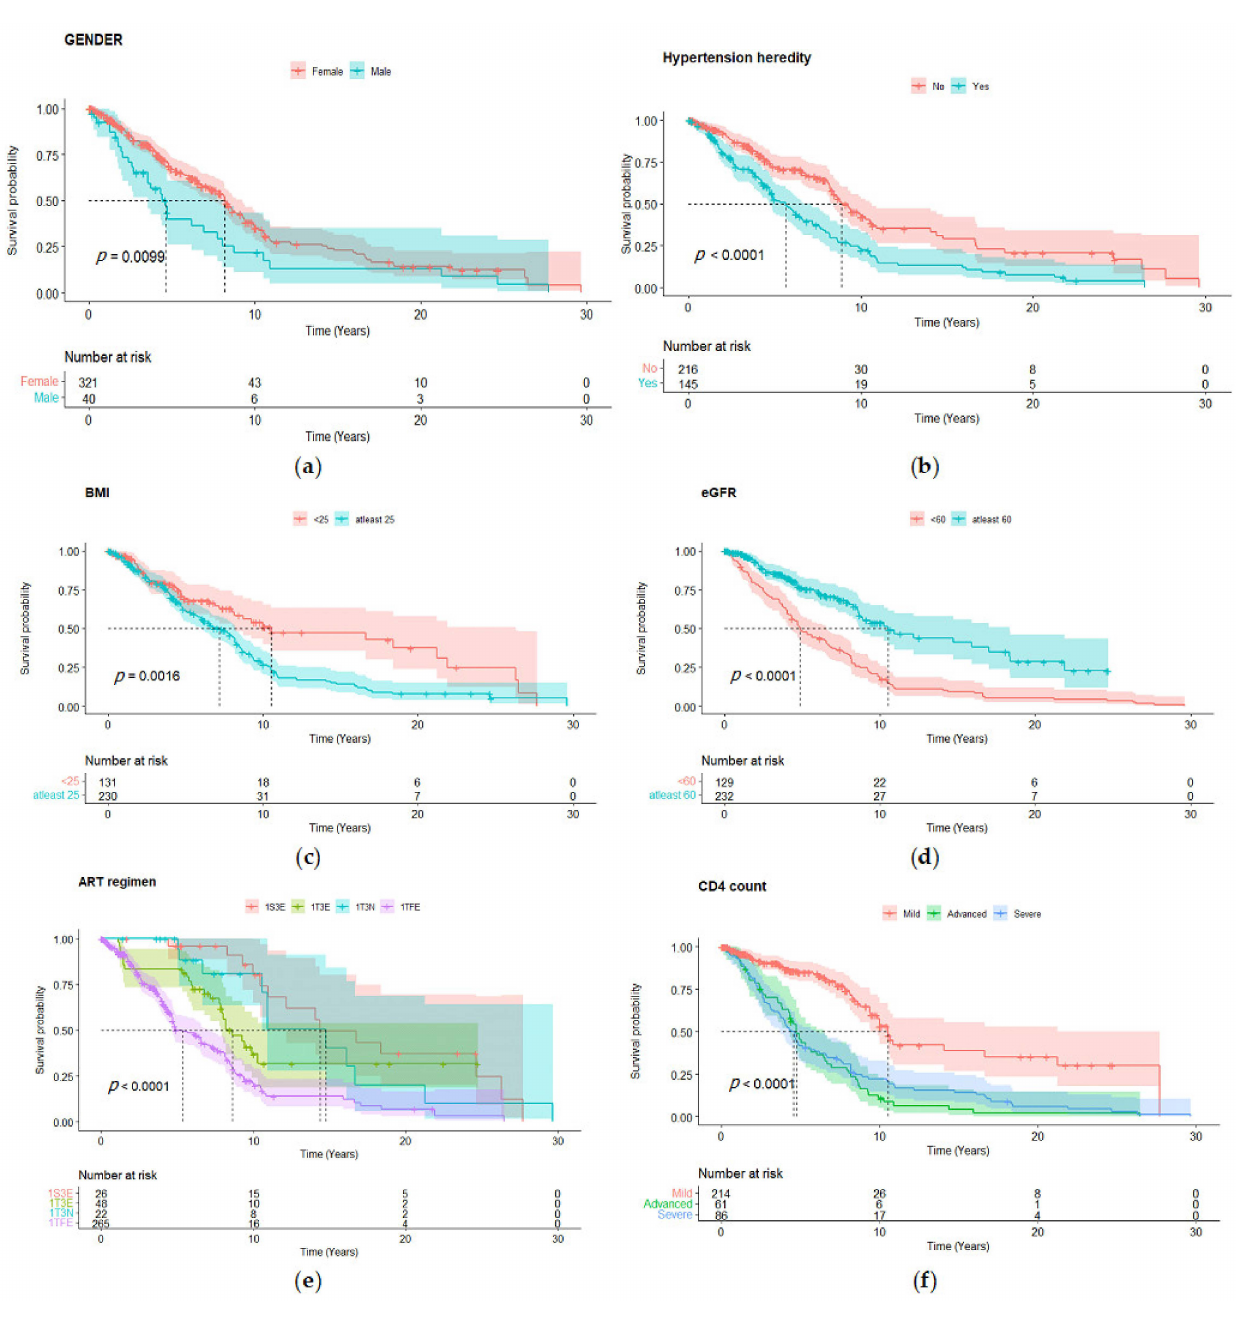
Figure 3. Kaplan–Meier curve and risk tables of hypertension development based on: ( a ) gender, ( b ) hypertension heredity, ( c ) BMI, ( d ) eGFR, ( e ) ART regimen, ( f ) CD4 count. BMI: body mass index; eGFR: estimated glomerular filtration rate; ART: antiretroviral therapy; HR: hazard ratio; CI: confidence interval; WHO: World Health